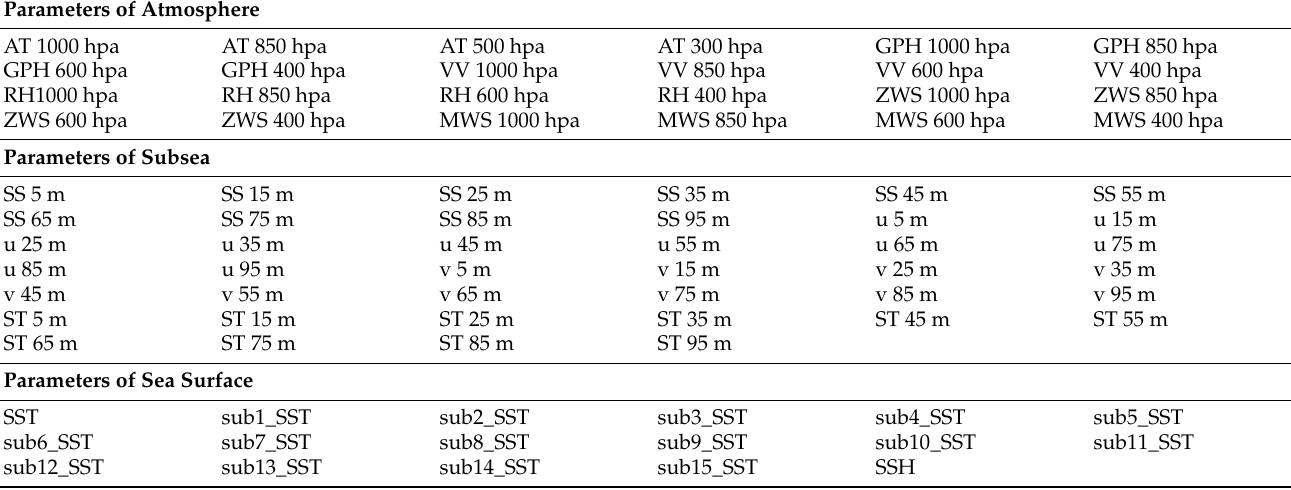
Table 1. 81 Factors used in the